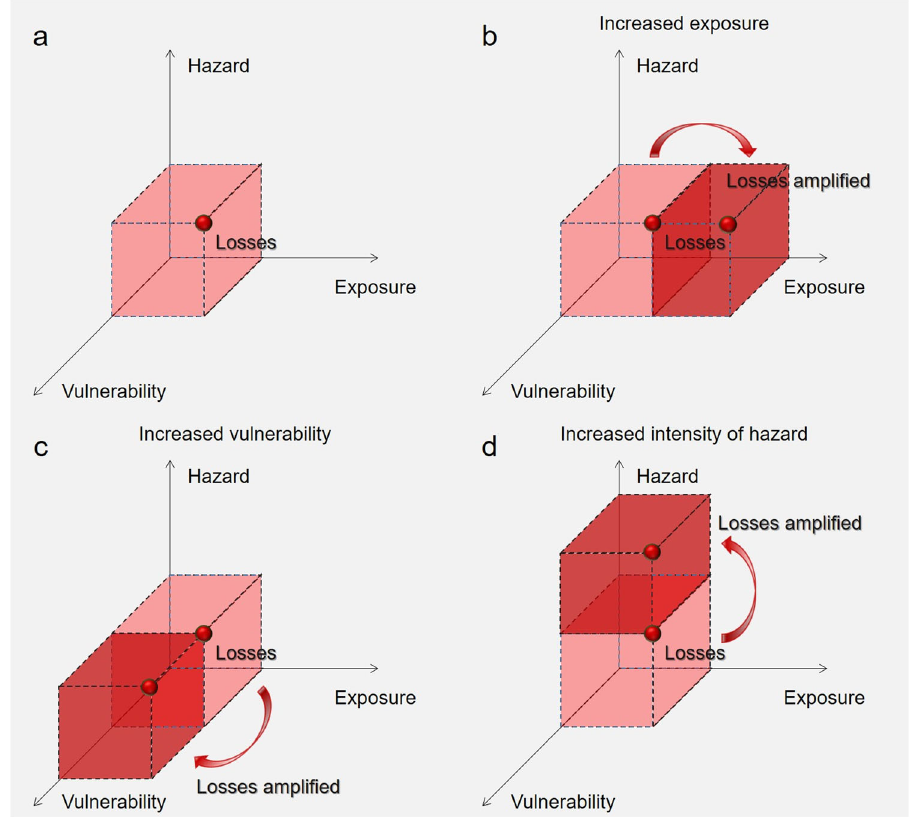
Fig. 1 The ampli fi cation effect of unreasonable human behaviours on natural disasters. a Mechanism of disaster formation. b – d Increased exposure, vulnerability or intensity of hazard due to unreasonable human behaviours ampli fi ed disaster losses. In a , the red squares represent disaster losses, which are determined by exposure, vulnerability and hazard. In b – d , the dark red squares represent ampli fi ed disaster losses due to increased exposure, vulnerability, or intensity of hazard caused by unreasonable human